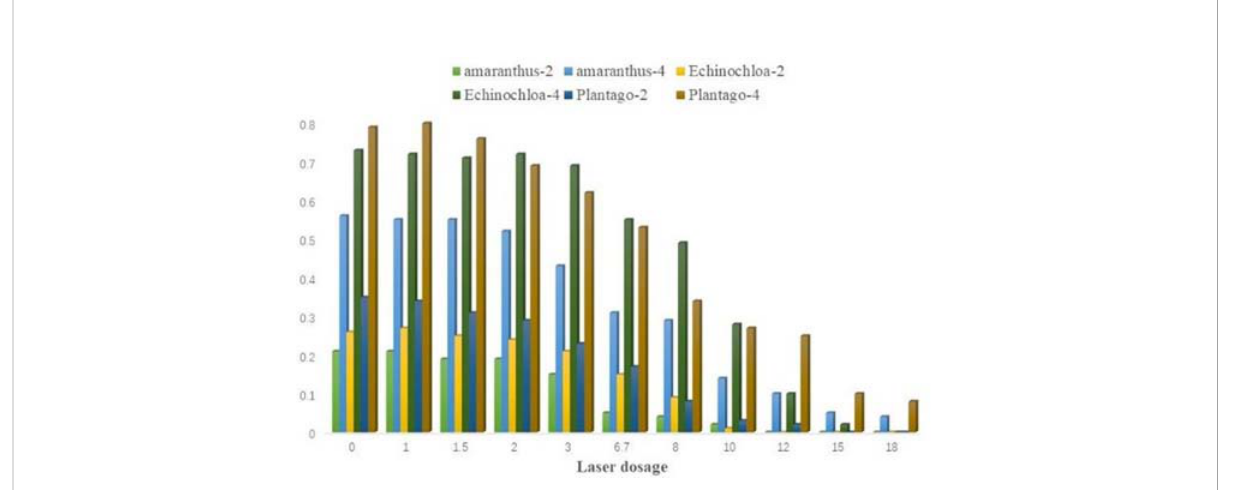
FIGURE 12 Effect drawing of laser irradiation.